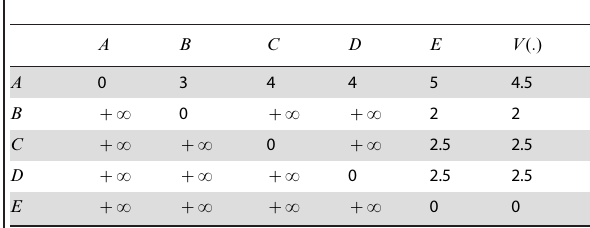
Table 1. Quasi-distances and Value function for example 2A.